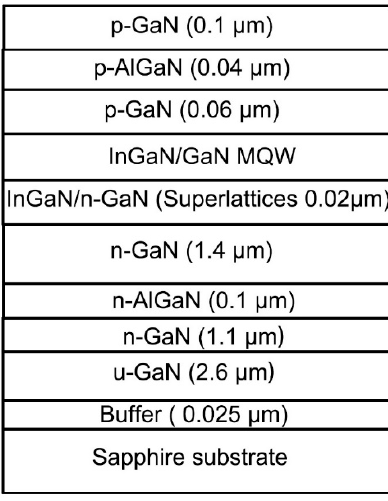
Figure 1. Scheme of the InGaN/GaN light-emitting diode (LED) in this work.